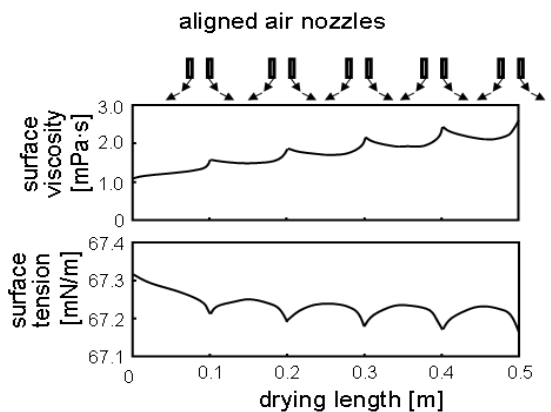
Fig. 2 Periodic variations in viscosity and surface ten- sion in air drier 9)